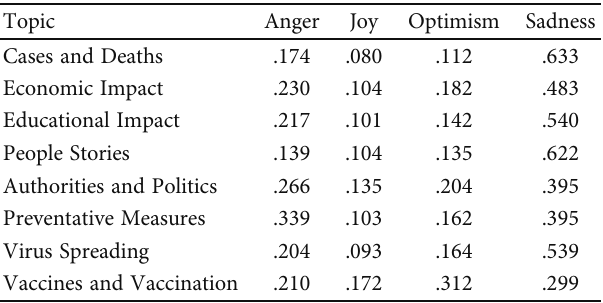
Note: table showing mean emotion scores in news tweet dataset, across entire period, for all news channels. Scores are emotion levels coded by the NLP model, ranging 0 to